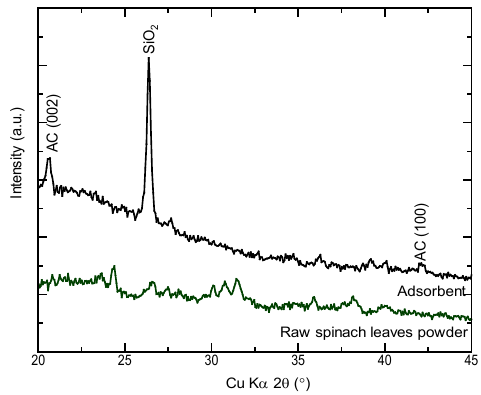
Fig. 1. XRD patterns of the raw sample (DSL) and spinach leaves powder adsorbent material (ASL-2)